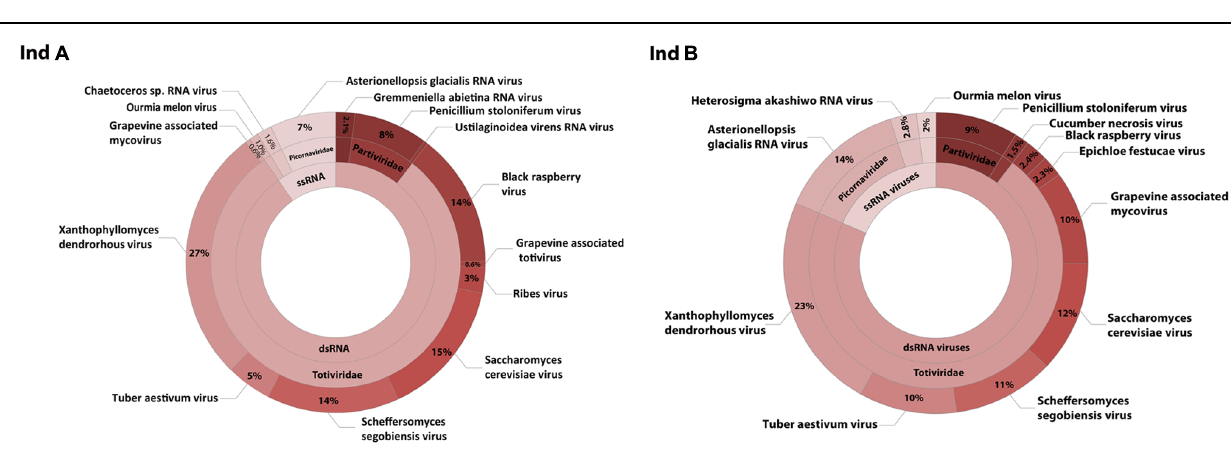
FIGURE 2 | RNA virome composition. Taxonomic classification of viral contigs based on significant blastx and tblastx results with an e -value cut off of smaller than 10 − 5 from two different D. pulchra individuals (A,B) . The viral abundance is based on the coverage of each contig as a relative quantitative